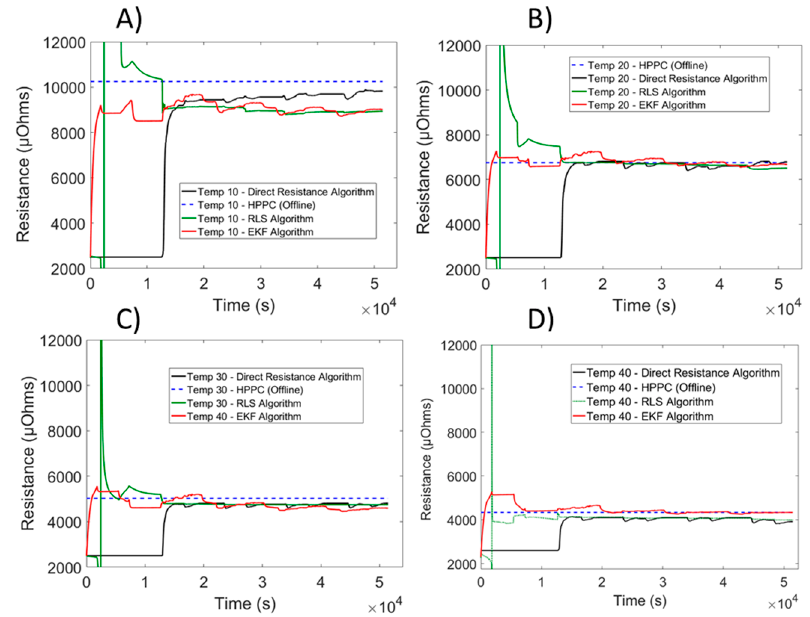
Figure 8. Resistance estimations from HPPC test, EKF algorithm, RLS algorithm and DRE algorithm for cell #2 (aged cell) at temperatures of 10 °C ( A ), 20 °C ( B ), 30 °C ( C ) and 40 °C ( D ).